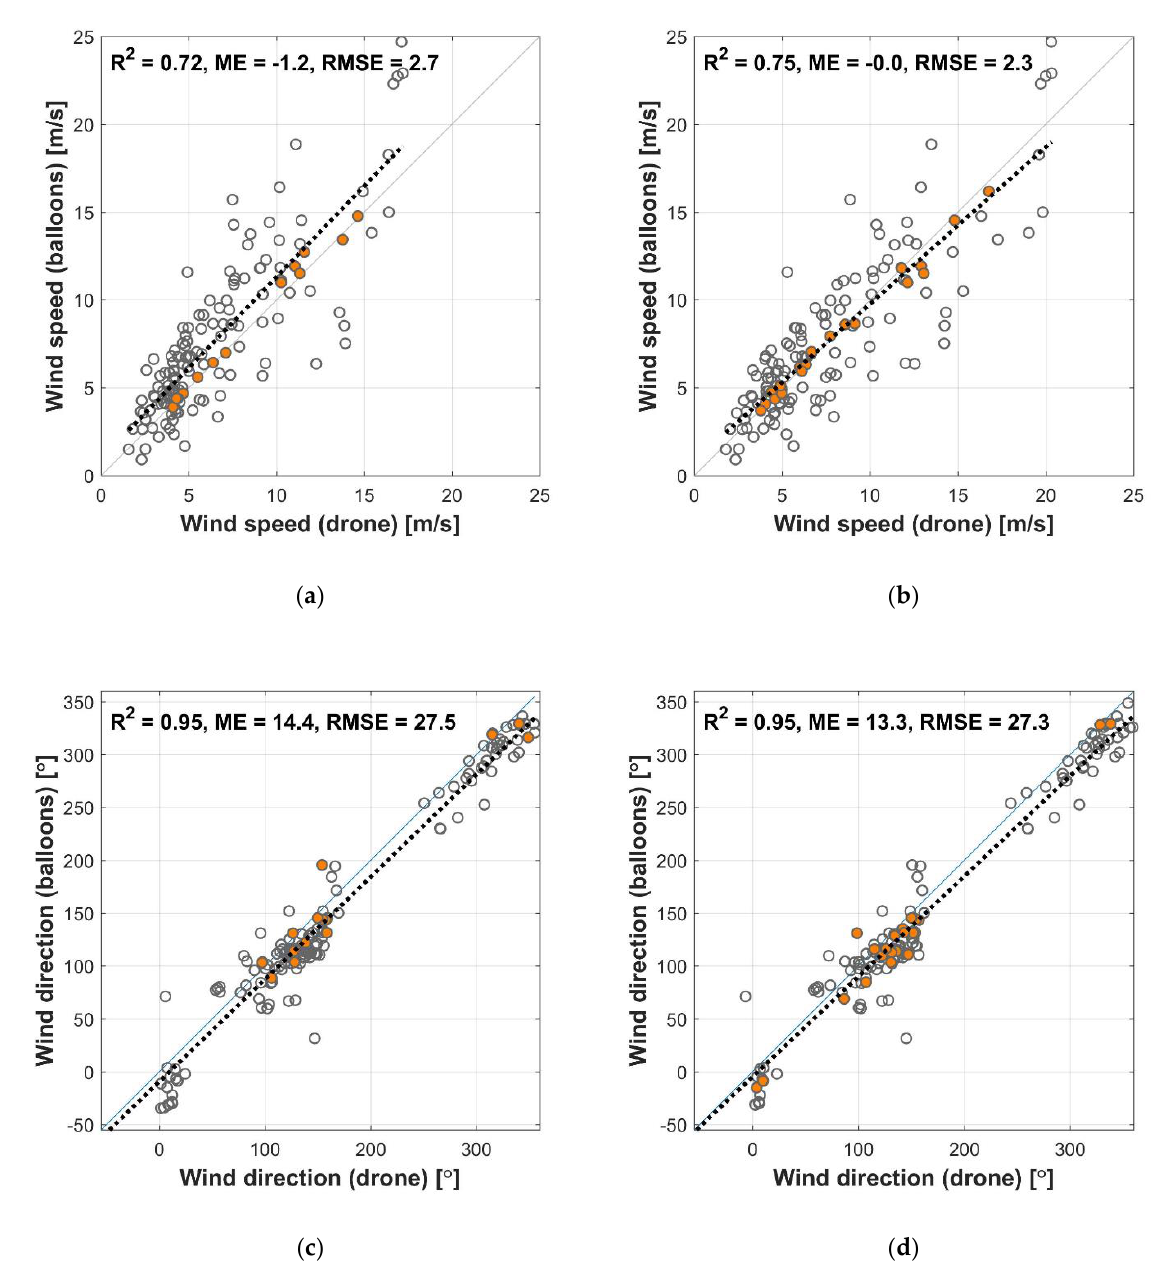
Figure 9. Comparison between balloon-based and drone-based vertical soundings for the wind speed ( a , b ) and direction ( c , d ) values, before ( a , c ) and after ( b , d ) applying correction for drone-estimated crosswind component. Orange dots indicate, when the drone-estimate wind speed lies within uncertainty range of balloon-based wind speed estimate, related with imperfect tracking of the balloon by the theodolite.